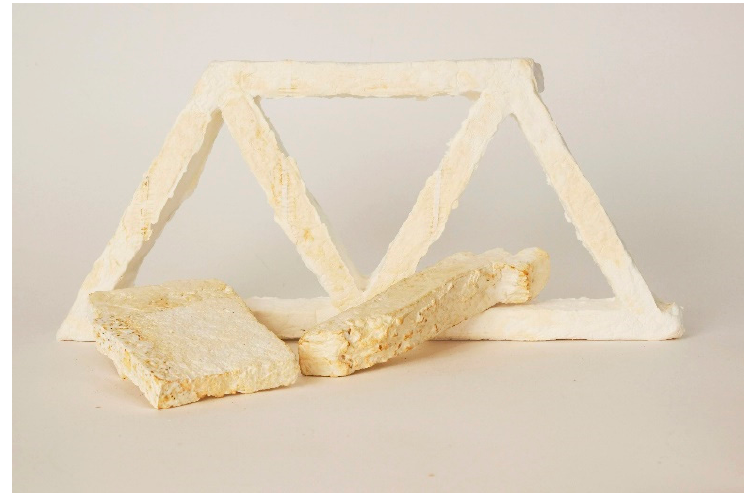
Figure 11. Truss structure made from cellulose pulp.